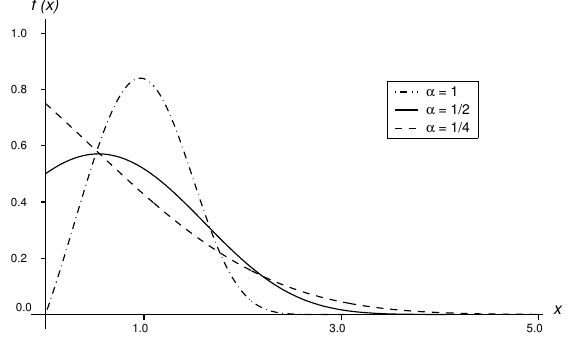
Figure 1. Density functions of the Muth distribution with parameters α = 1 , 1 / 2 , 1 /